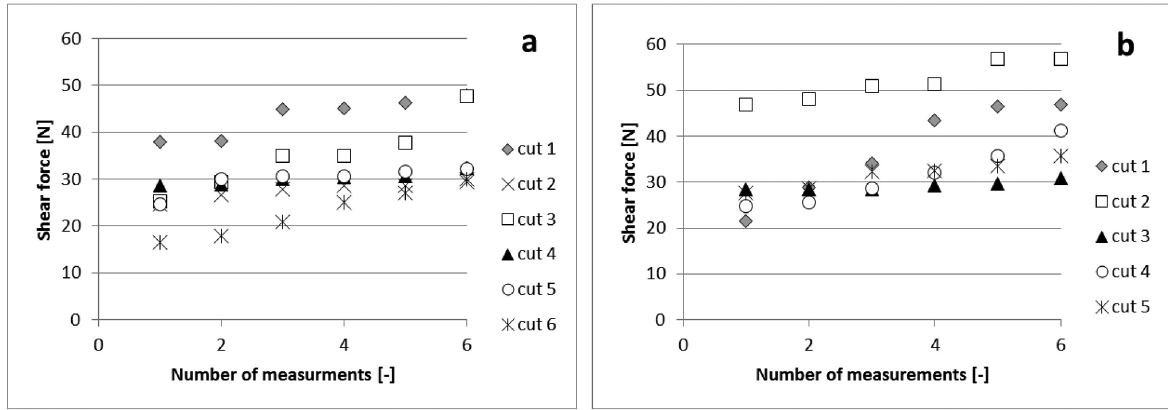
Figure 3 - (a). Shear force values [N] for the analyzed 6 cuts of Polish Landrace breed animals; (b). Shear force values [N] for the analyzed 5 cuts of Polish Landrace x Duroc crossbreed